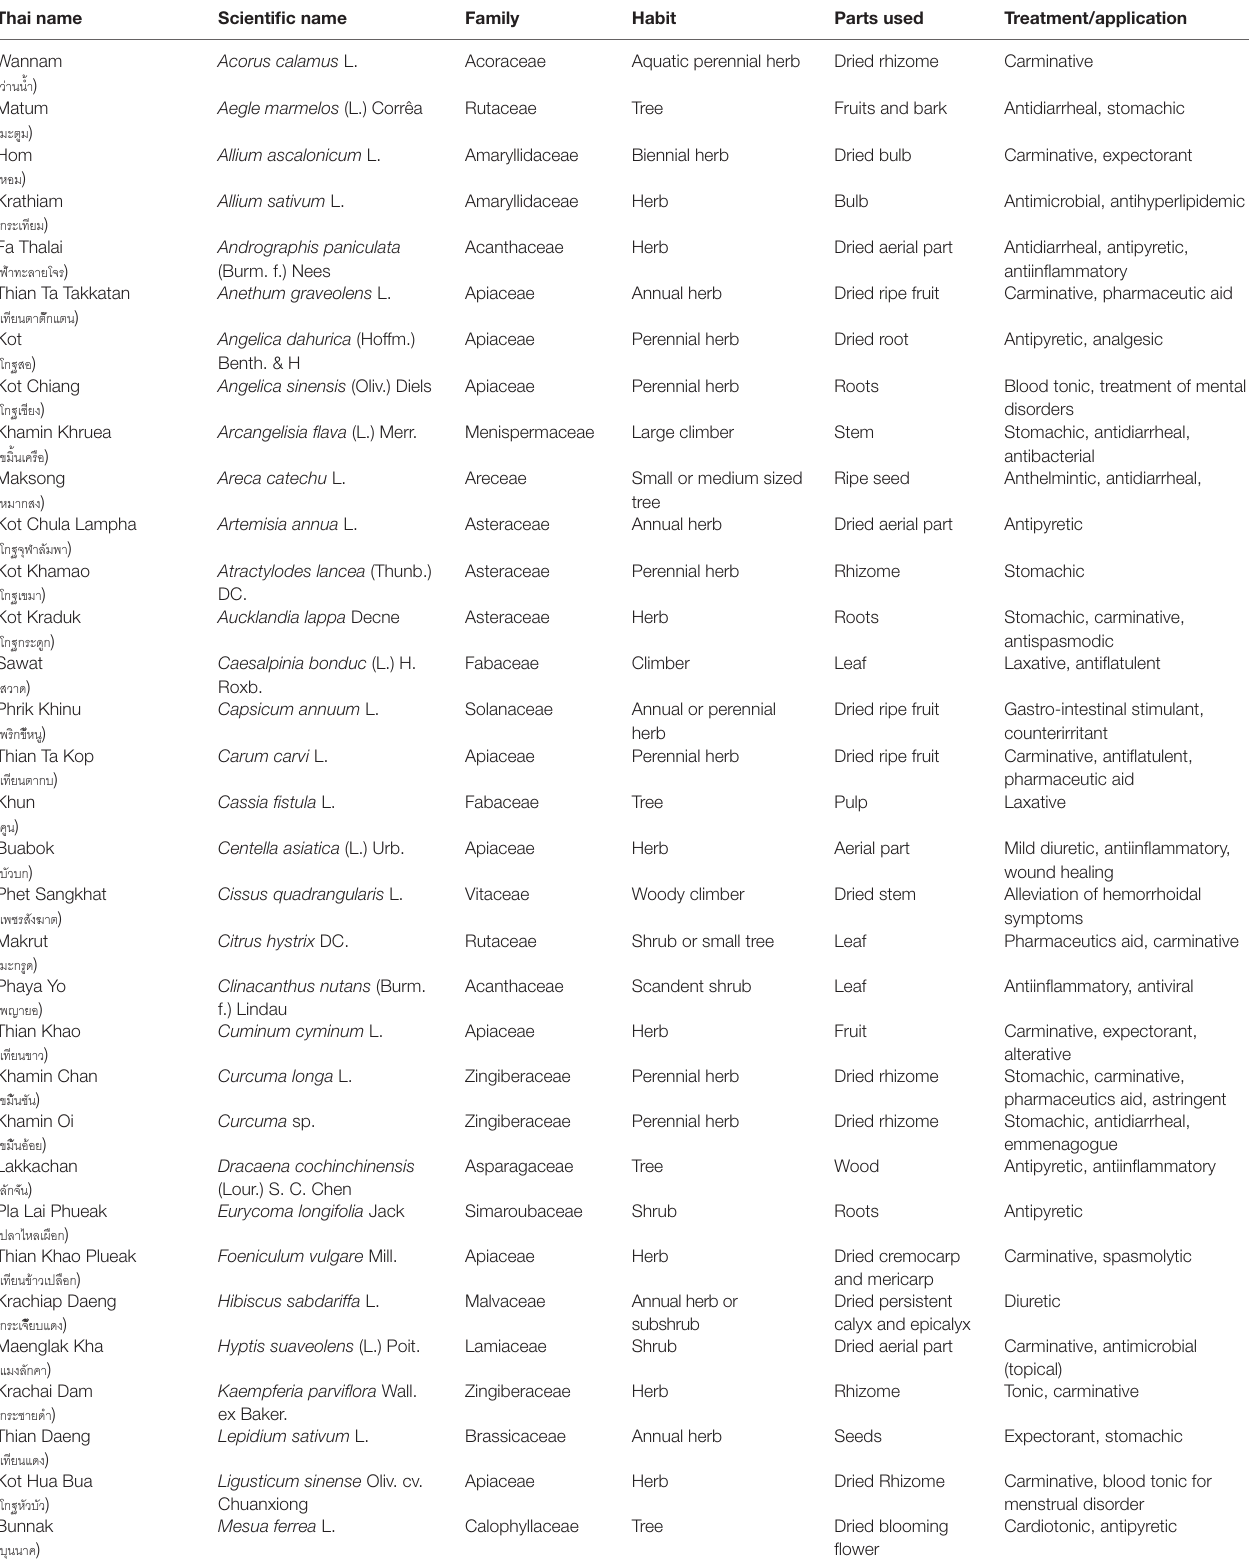
TABLe 1 | Information on the 66 documented medicinal plants used in the Thailand Herbal Pharmacopoeia